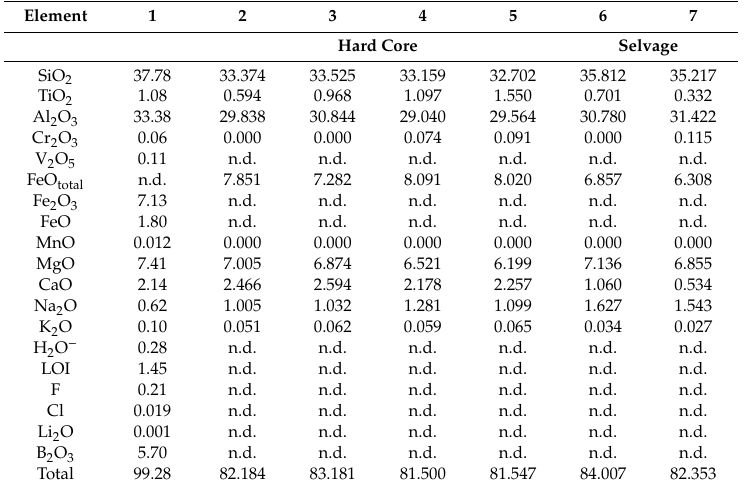
Table 2. Chemical composition of tourmaline from the rocks of the DW block (wt %). Element